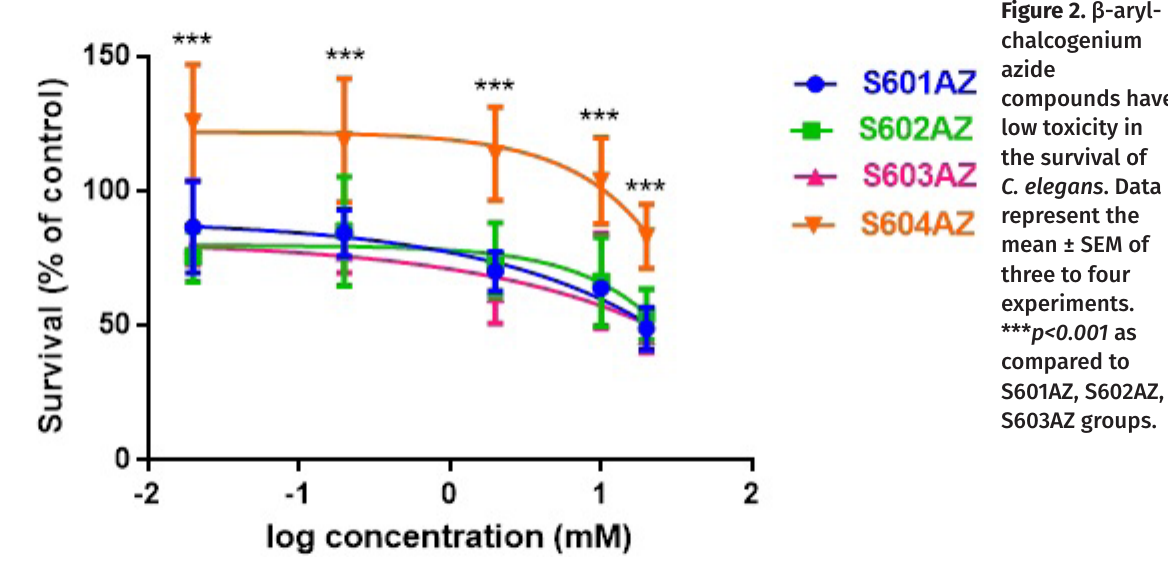
Figure 2. β-aryl-